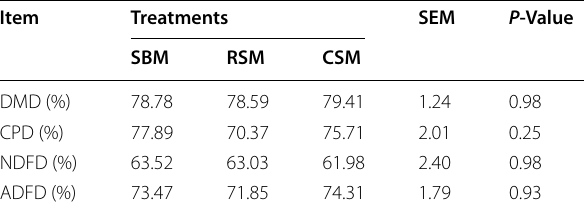
Table 2 Nutrients digestibility affected by different protein source of diets